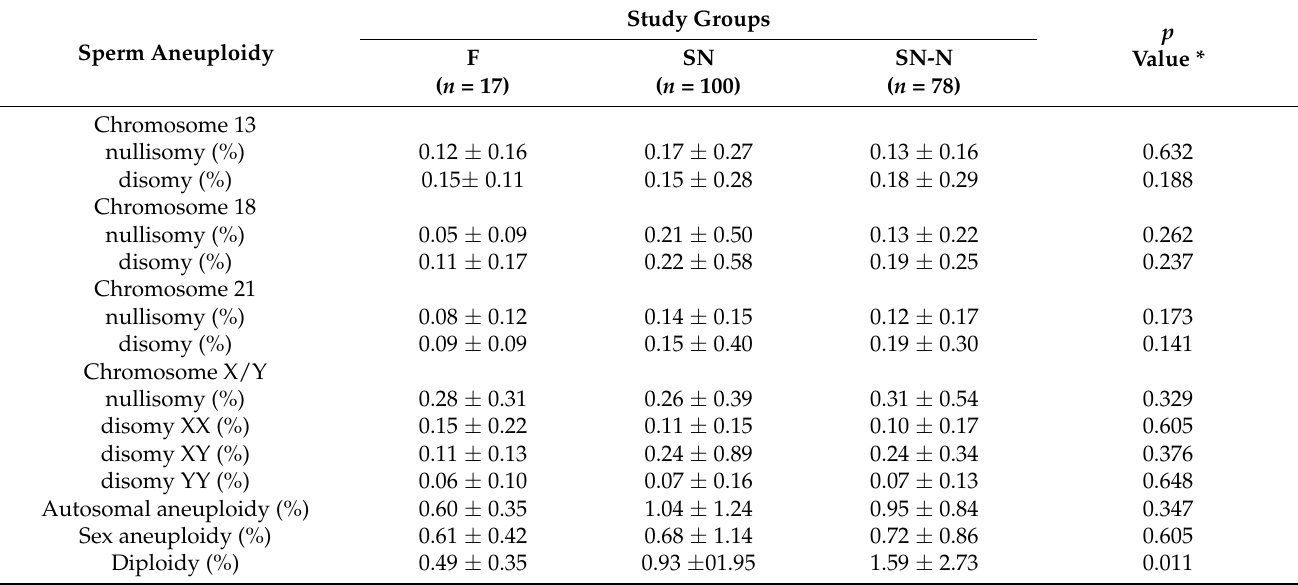
Table 1. Sperm aneuploidy in the fertile and subfertile groups (F = fertile population; SN = subfertile population with normozoospermia; SN-N = subfertile non-normozoospermic population).